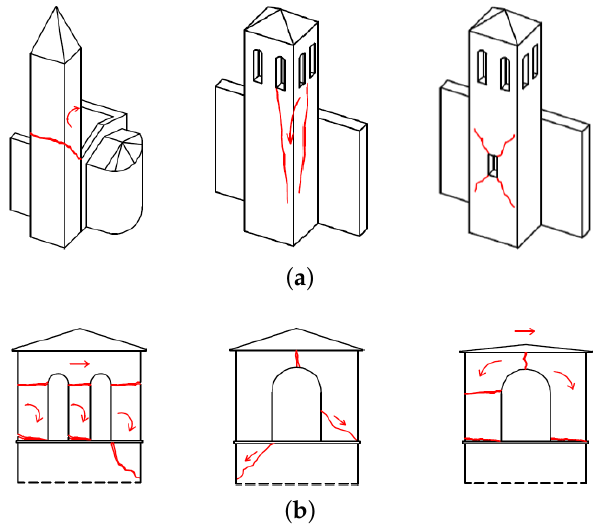
Figure 1. Collapse mechanisms: ( a ) tower stem; ( b ) tower top